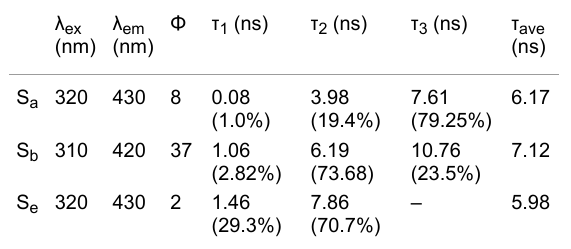
Table 2: The excitation ( λ ex ) and emission ( λ em ) wavelengths, quan- tum yield ( Φ ), lifetime components ( τ 1 , τ 2 , τ 3 ) and fluorescence lifetime ( τ ave ) for S a , S b and S e